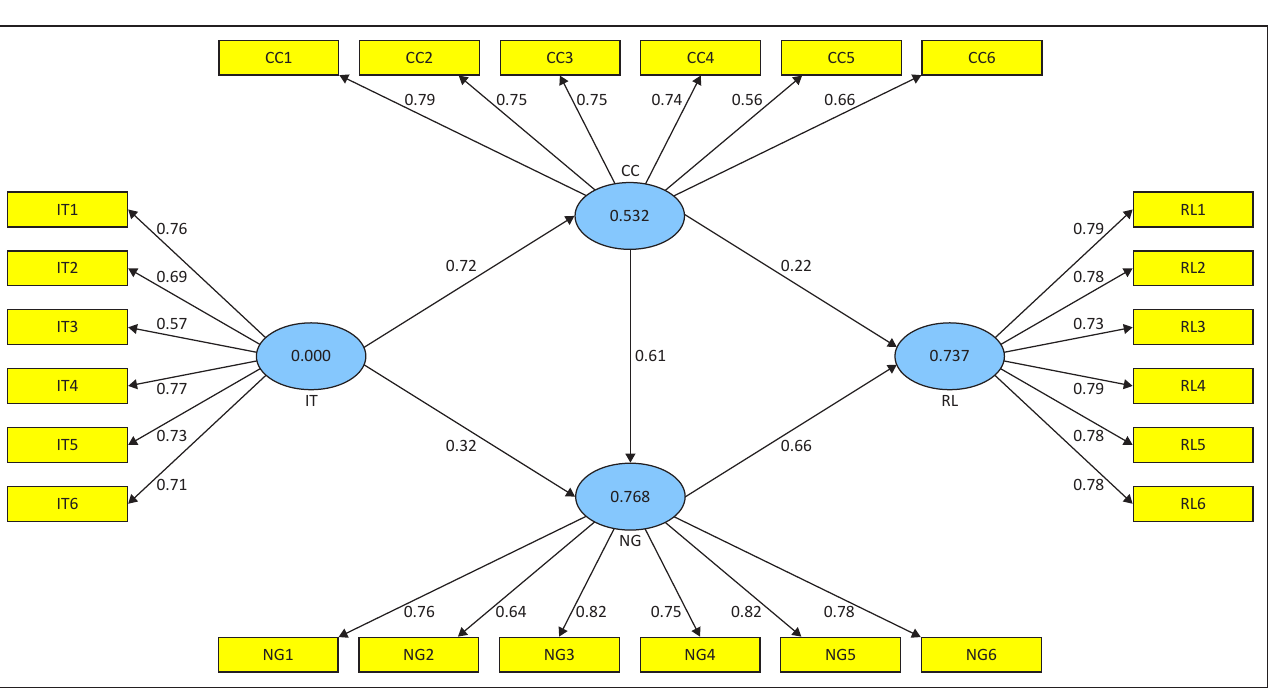
FIGURE 2: Measurement and structural model results.